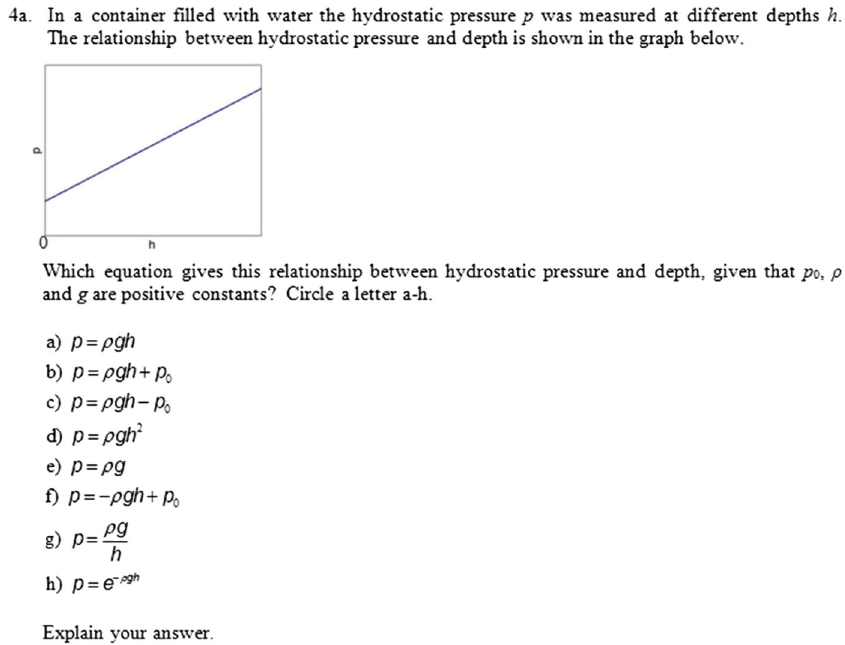
FIG. 2. Example of a test item about an increasing affine function in a physics context, translating from a graphical to a symbolic